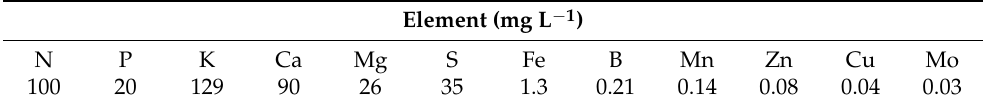
Table 1. Composition of the full-strength, custom nutrient solution used in both